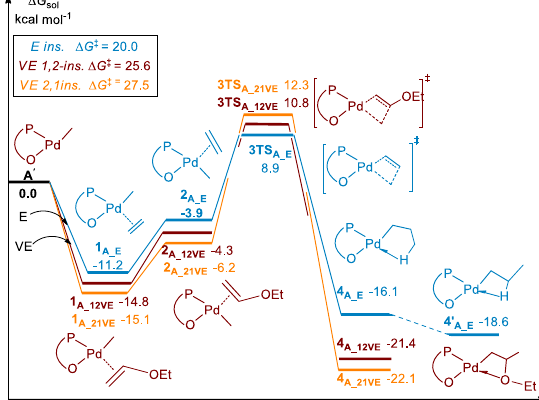
Figure 1. Energy profiles for chain initiation in copolymerization with ethylene and vinyl ether catalyzed by neutral active species A′ .